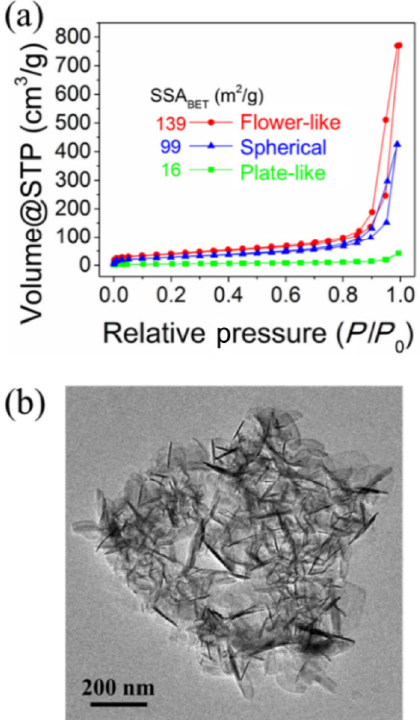
Fig. 5 (a) N 2 isotherms of LDHs with different morphology at standard temperature and pressure; (b) TEM image of flower-like LDH sample.